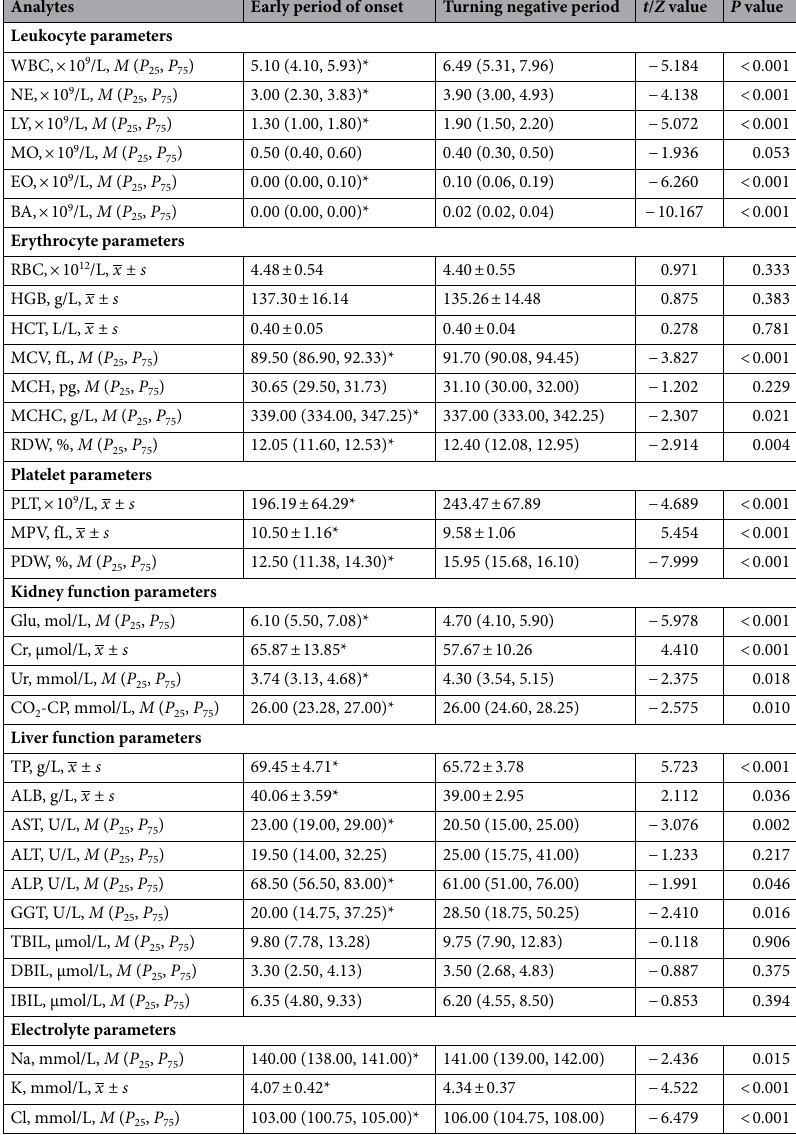
Table 2. Laboratory characteristics of patients with moderate COVID-19. WBC white blood cell, NE neutrophil count, LY lymphocyte count, MO monocyte count, EO Eosinophil, BA basophil, RBC red blood cell, HCT hematocrit, HGB hemoglobin, MCV mean corpuscular volume, MCH mean corpuscular hemoglobin, MCHC mean corpuscular hemoglobin concentration, RDW red blood cell distribution width, PLT platelet count, MPV mean platelet volume, PDW platelet distribution width, Glu Glucose, Cr creatinine, Ur urea, CO 2 -CP carbon dioxide combining power, TP total protein, ALB Albumin, AST aspartate aminotransferase, ALT alanine aminotransferase, ALP alkaline phosphatase, GGT γ-glutamyl transpeptidase, TBIL total